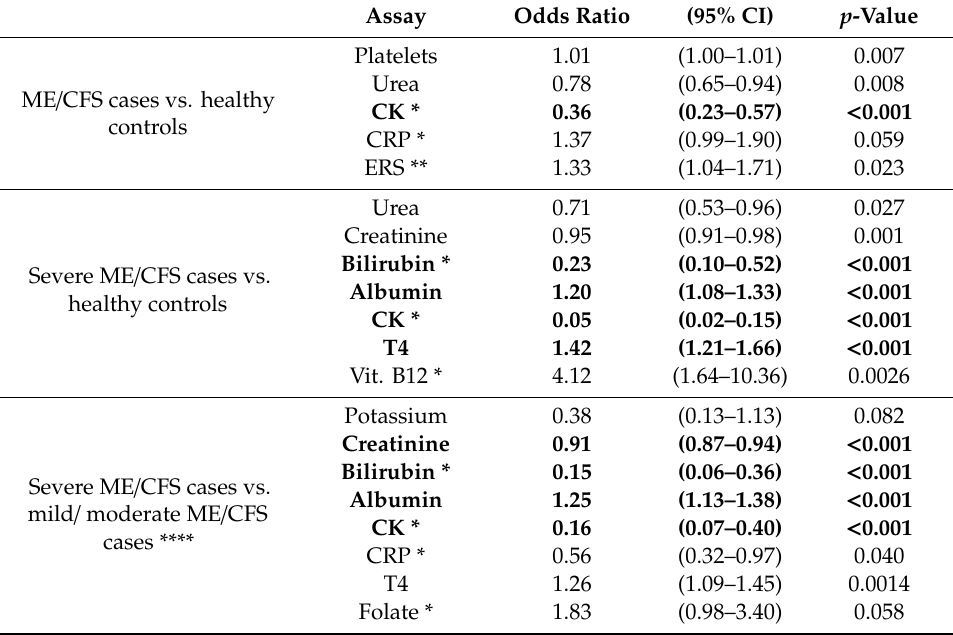
Table 4. Laboratory test results in ME / CFS cases and healthy controls (adjusted analysis ***). Assay (95%